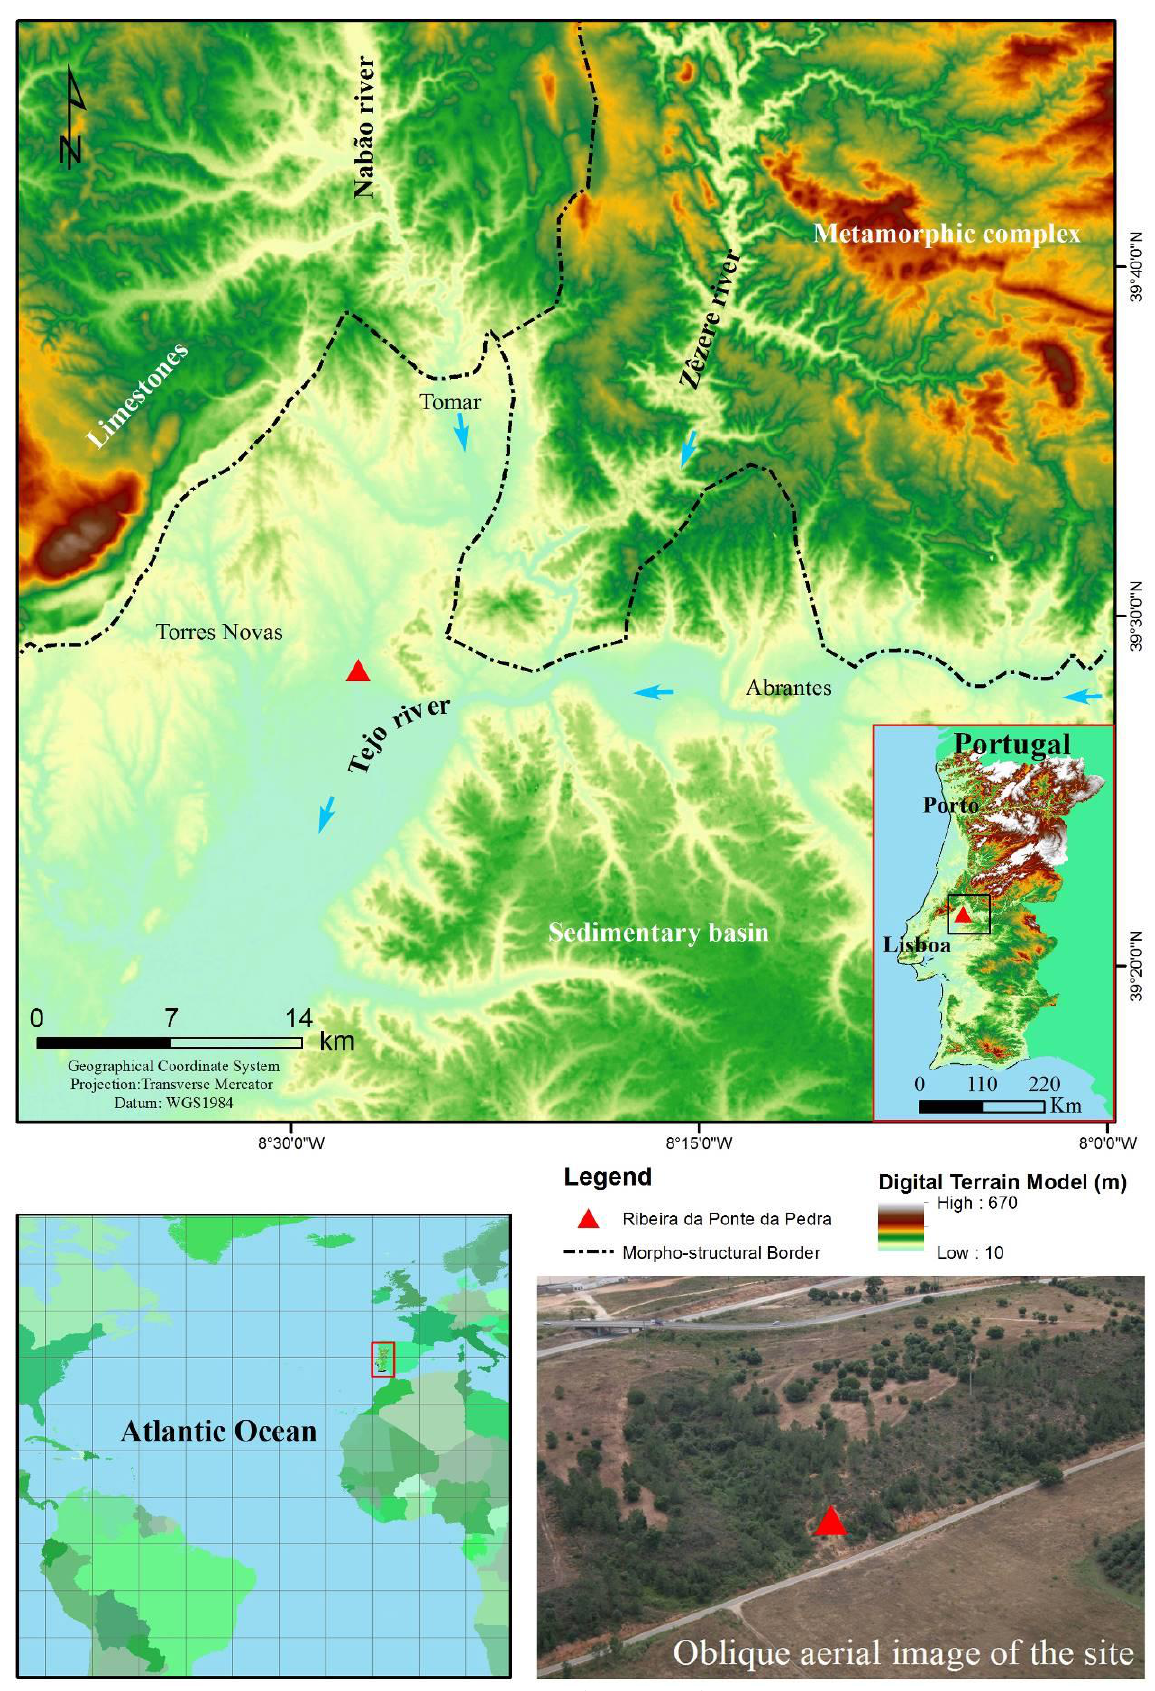
Figure 2. Ribeira da Ponte da Pedra: location of the site (red triangle). Geographical coordinate system projection: Transverse Mercator. Datum: